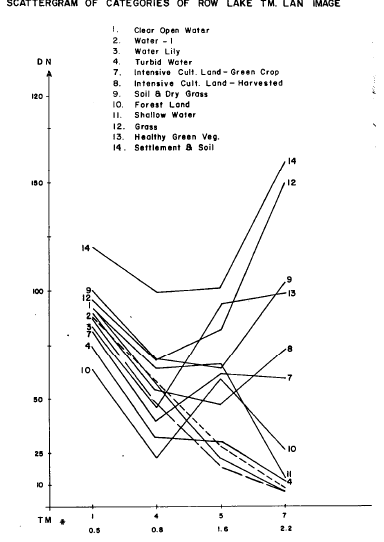
Figure 2. Scategrams of land cover classes for TM bands 1, 4, 5,